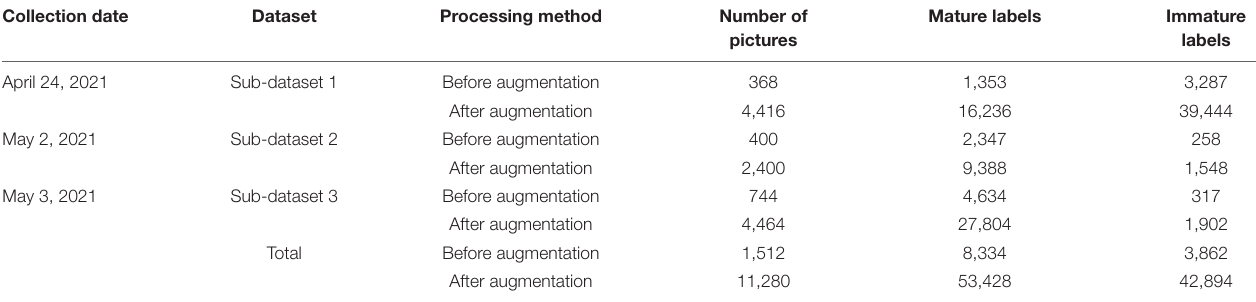
TABLE 1 | The number of datasets before and after augmentation.